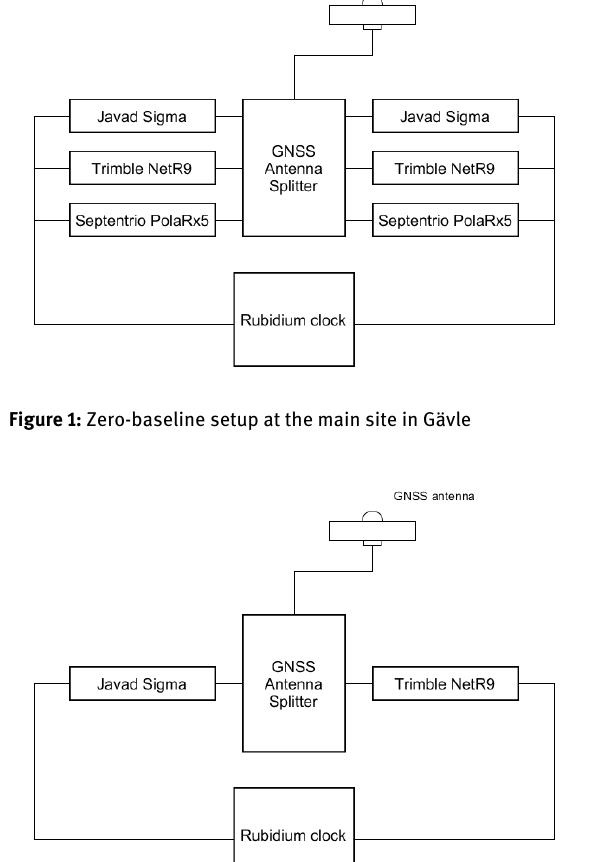
were connected to the same choke ring antenna of type, JAVRINGANT_DM. Also at the secondary site a choke ring antenna of the same type was used.